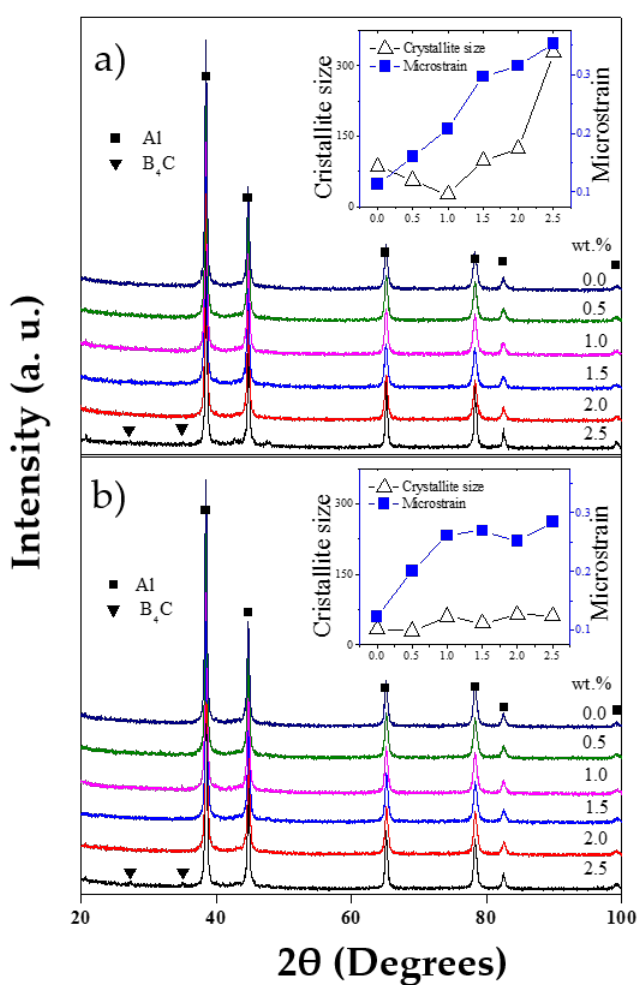
Figure 3. X-ray diffraction (XRD) diffraction patterns, crystallite size and microstrains as a function of the B 4 C content: ( a ) 1 h and ( b ) 2 h of milling.